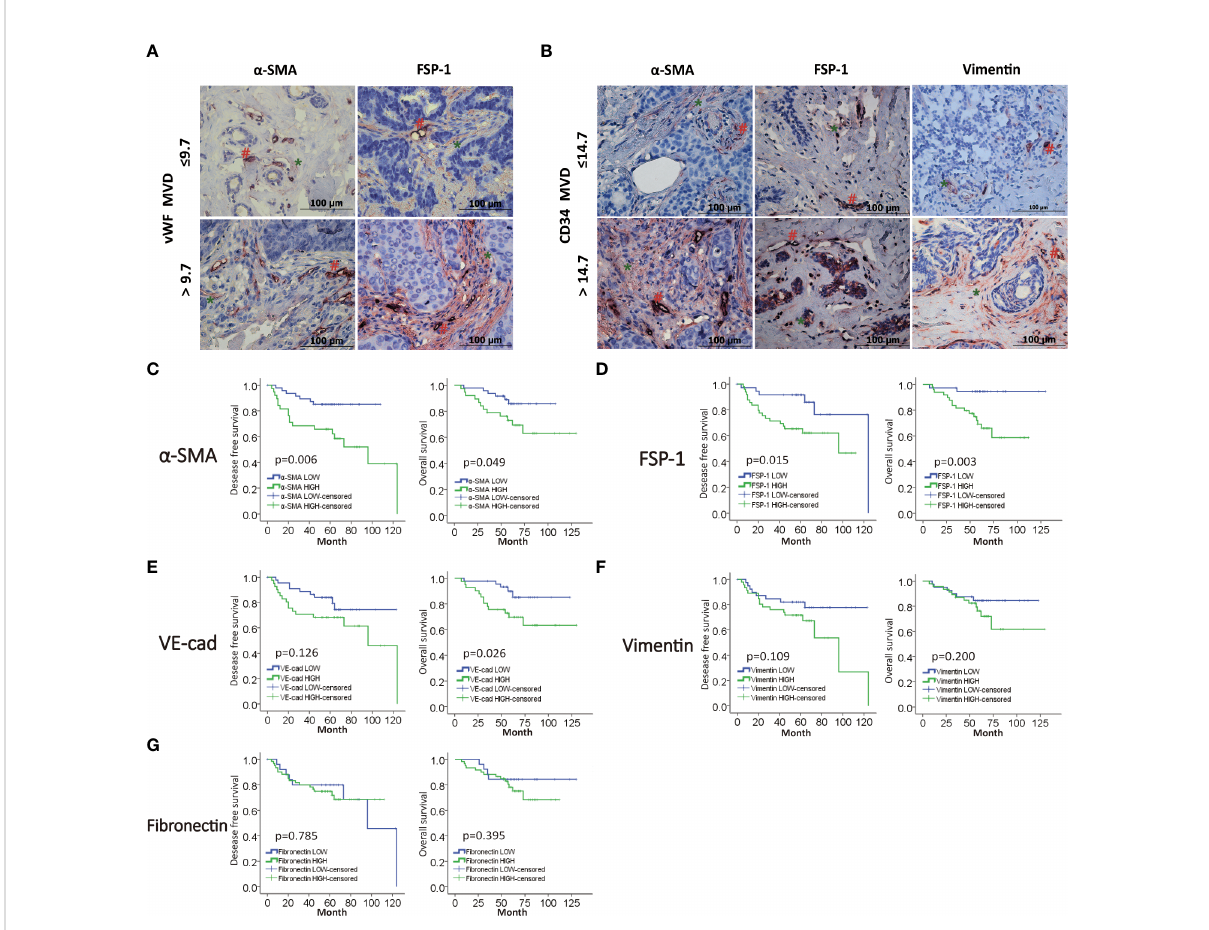
FIGURE 2 MVD level is positively correlated with EndMT markers in breast cancer. (A,B) Representative images of double-IHC staining of vWF, CD34 (brown, with red “ # ” ) and either a -SMA, FSP-1 or Vimentin (red, with green “ * ” ) in samples from IDC patients. (C – G) Kaplan-Meier analysis of DFS and OS of IDC patients from our cohort by a -SMA, FSP-1, Vimentin, VE-Cadherin and